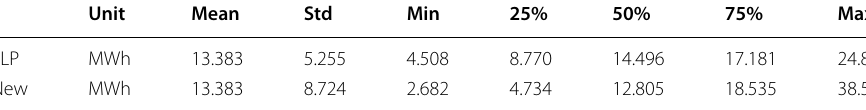
Table 6 Descriptive values for new method and SLP electricity time series in MVGD